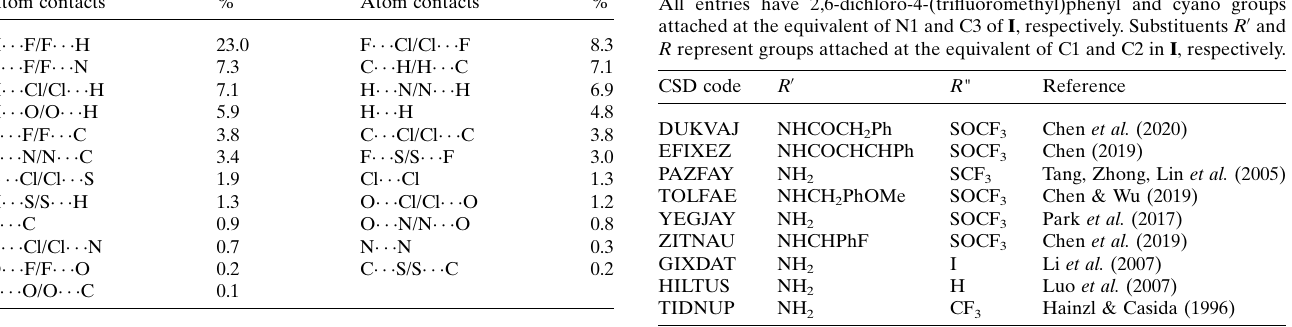
Table 2 Atom–atom contact coverages (%) in I . Atom contacts